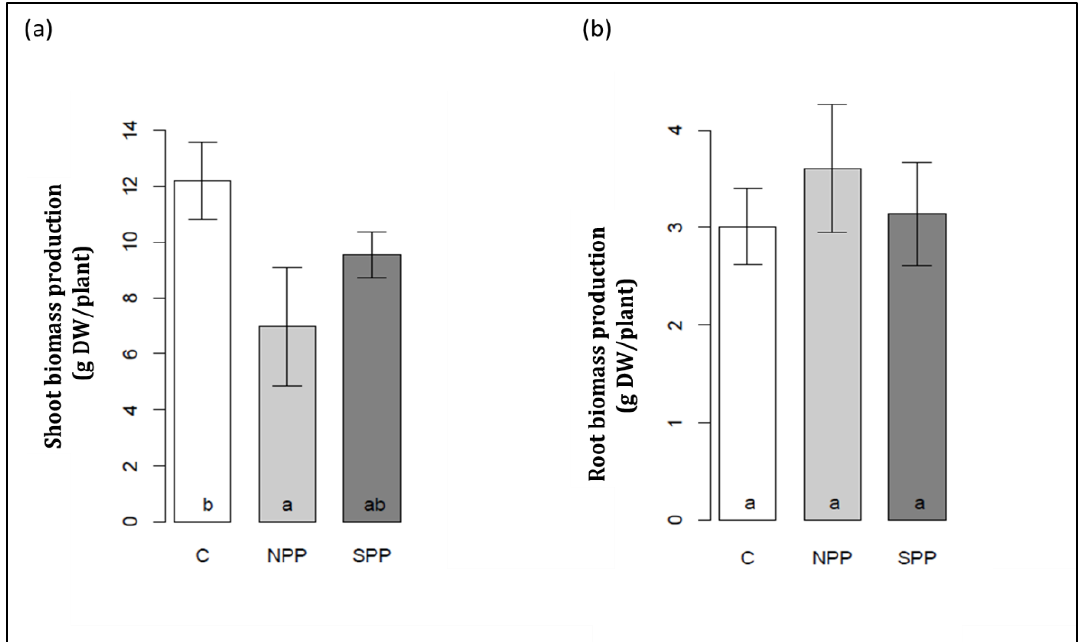
Figure 2. Effect of cross-tolerance on shoot biomass ( a ) and root biomass ( b ) of olive plants subjected to subsequent drought stress. Significant differences between the means (at p < 0.05, according to ANOVA) appear with different letters. Values are means ± standard error ( n = 6), where ‘ n ’ is the number of replicates for each group.